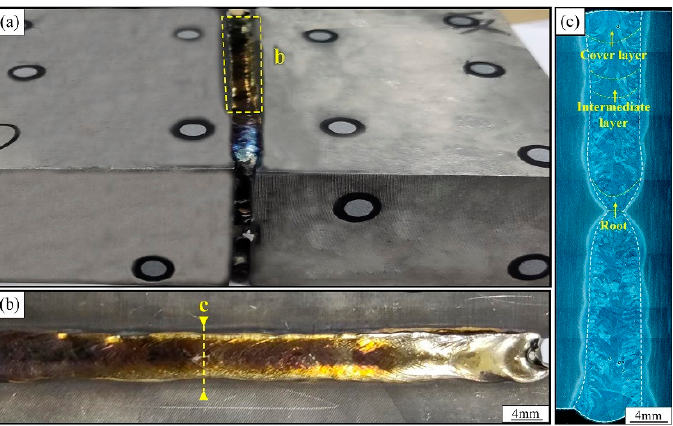
Figure 4. Macro forming of the 40 mm-thick TC4 titanium alloy narrow gap laser welded joint: ( a ) the macro forming of welded joint, ( b ) the cover layer, ( c ) the joint